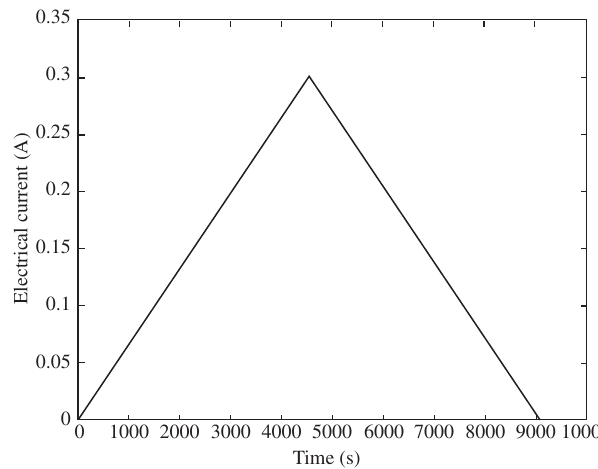
Figure 4. Electrical current waveform used to perform thermal cycles in the SMA wire samples.